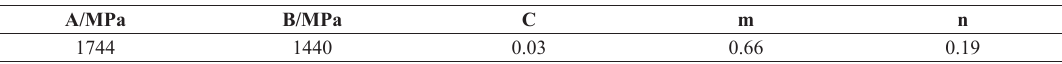
Table 2. GCr15 bearing steel J-C model parameters.